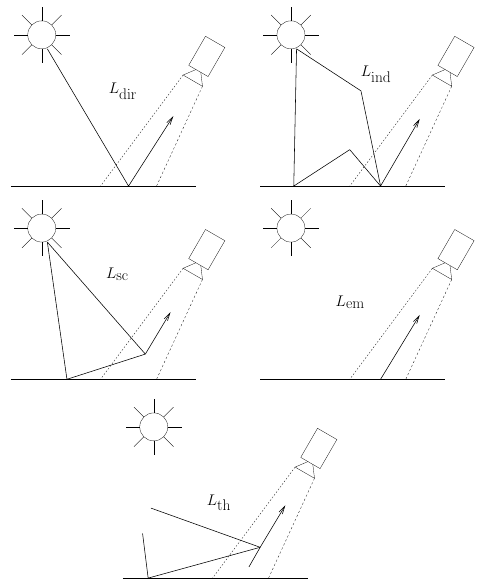
Figure 2: The at-sensor radiance can be split into 5 parts. L ind , L sc , and L th are only nonzero in the presence of an